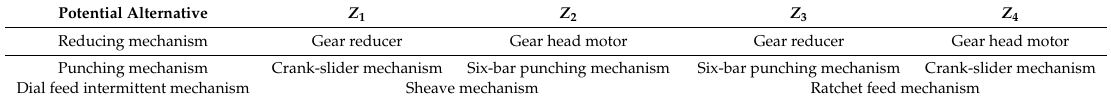
Table 1. Four design schemes (potential alternatives) of punching machine